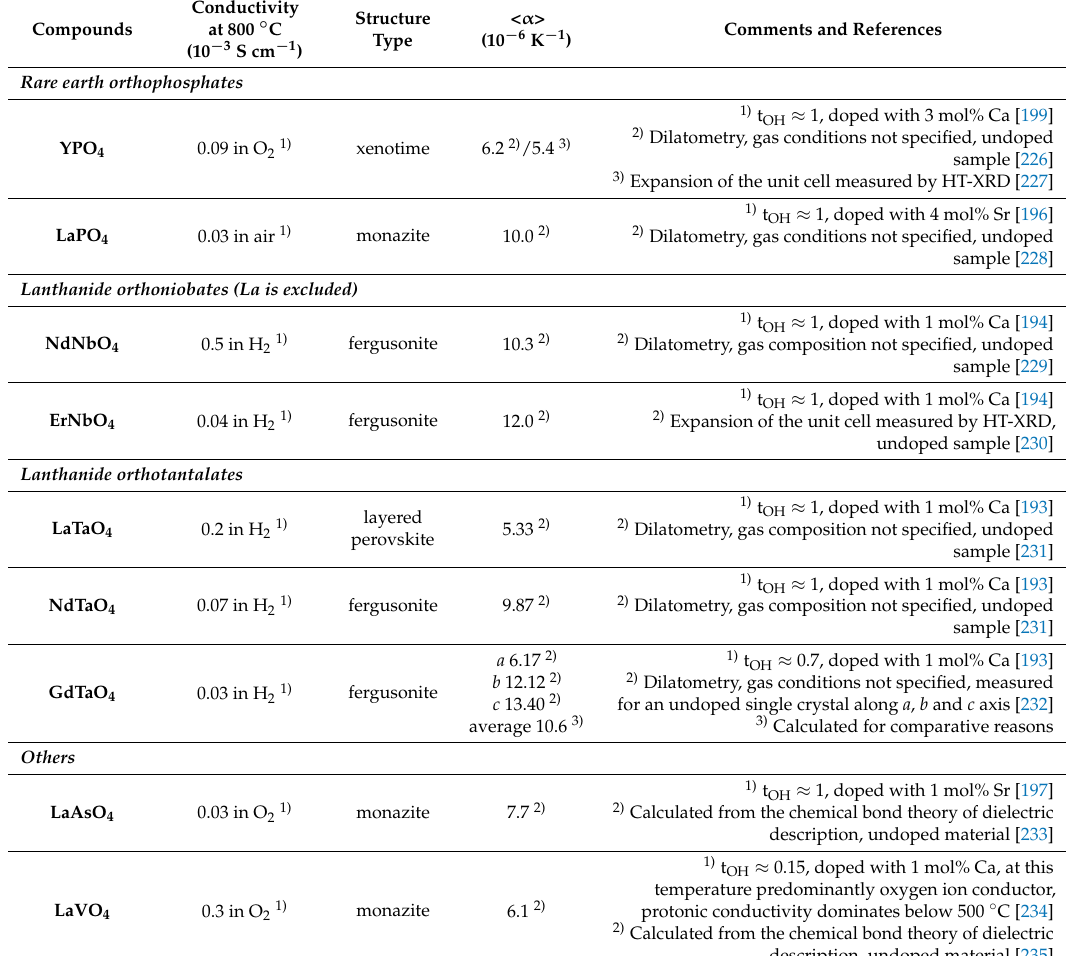
Table 5. Other ABO 4 compounds and their crystal structure, conductivity at 800 ◦ C in moist conditions and thermal expansion